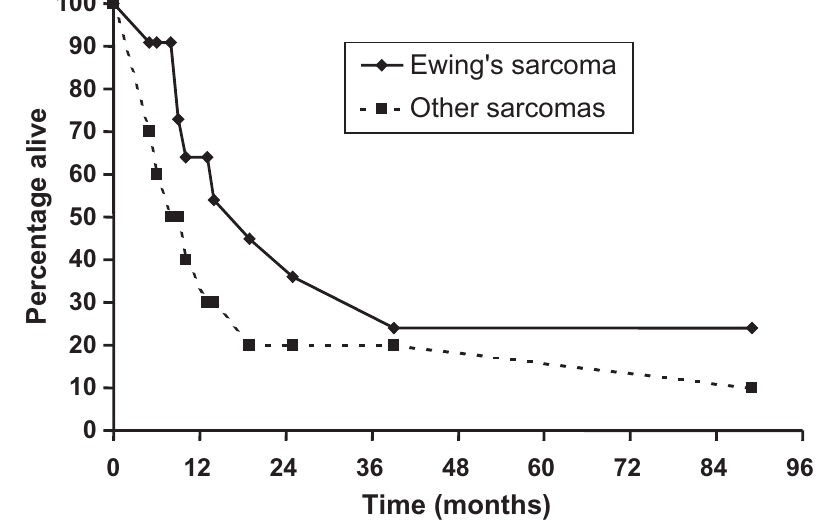
Fig. 3. Kaplan–Meier survival curves according to histological type at time of diagnosis. P ¼ non-significant.